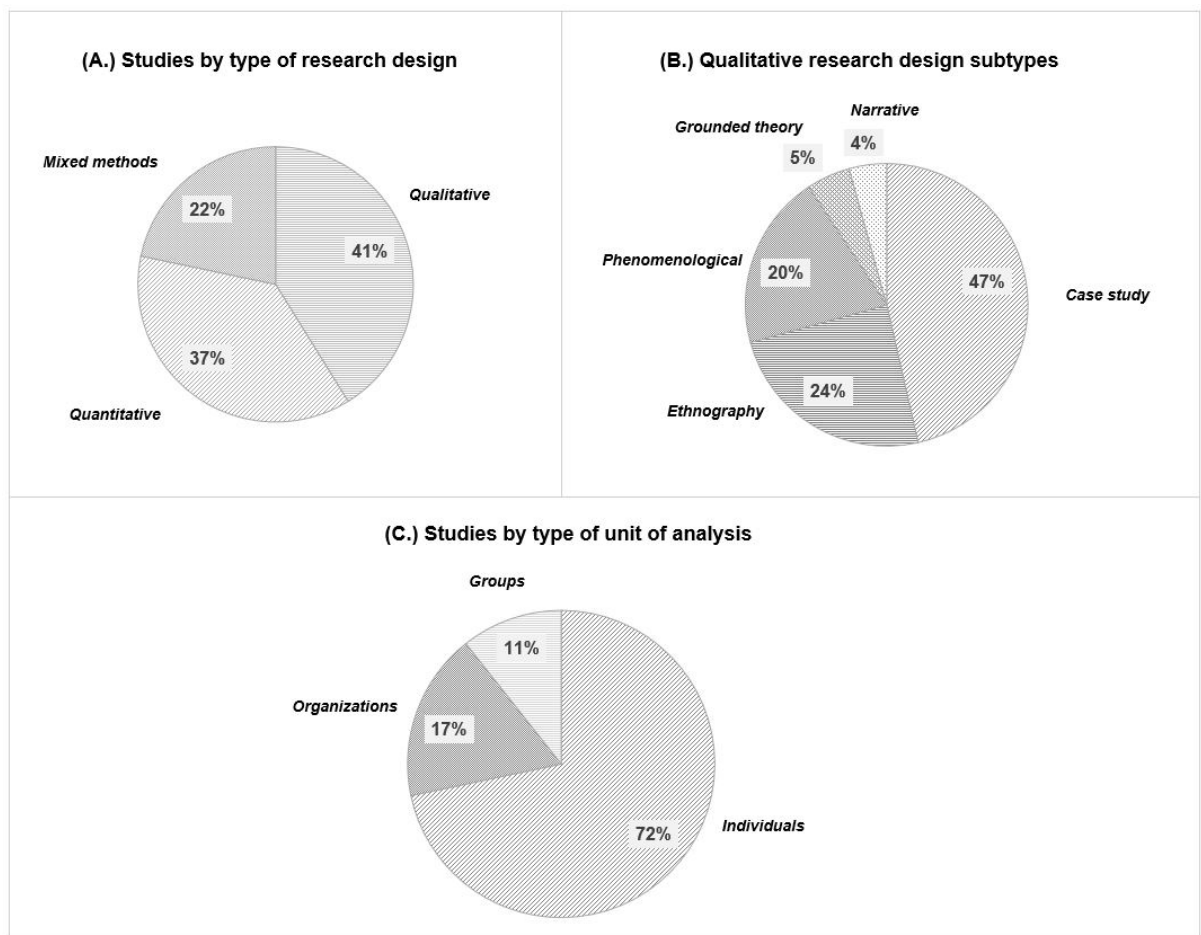
Figure 8. ( A ). Studies by types of research design ( n = 272), ( B ). Qualitative research design studies Figure 8. ( A .) Studies by types of research design ( n = 272), ( B .) Qualitative research design studies sub-types ( n = 112), ( C ). Studies by unit of analysis ( n = 272). sub-types ( n = 112), ( C .) Studies by unit of analysis ( n =